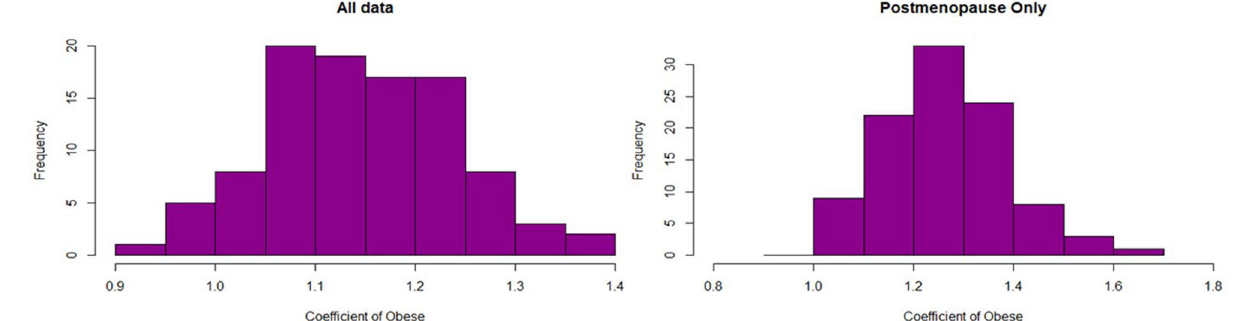
Figure 1. Histograms of coefficients of variable O (Obese) for Cox models trained on 100 bootstrap samples, illustrating that the distribution of the coefficients agrees with the reported confidence intervals for